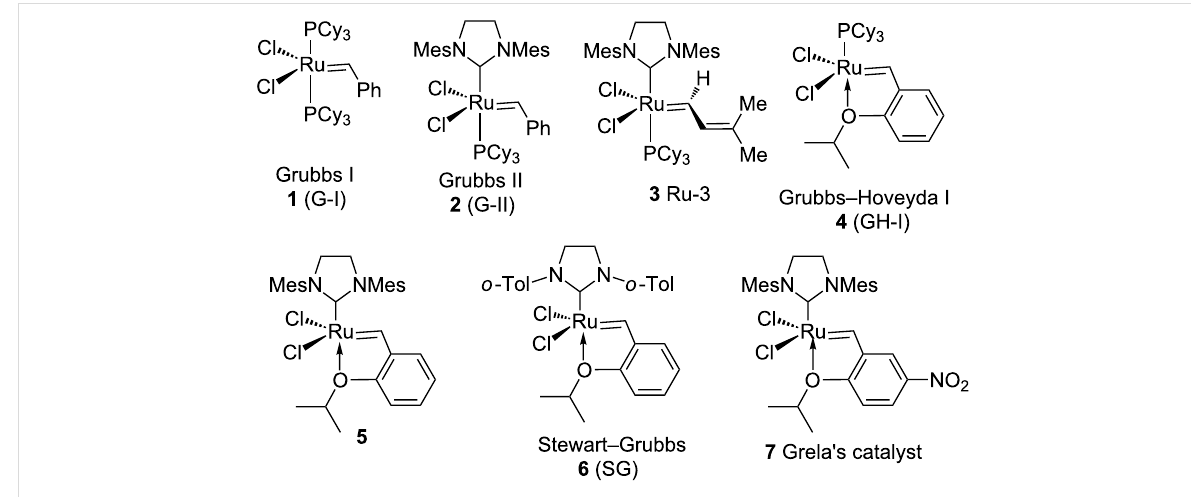
Figure 1: Ruthenium alkylidene catalysts used in RRM processes.